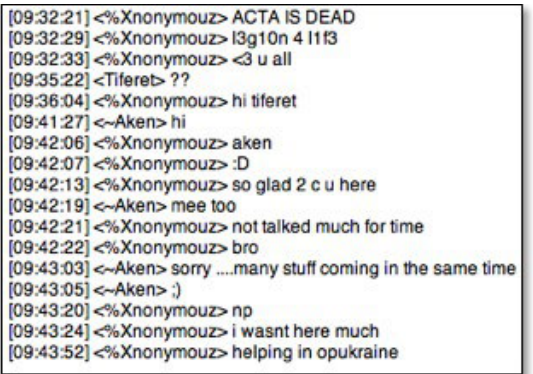
Figure 10: further example of Op Green Rights IRC